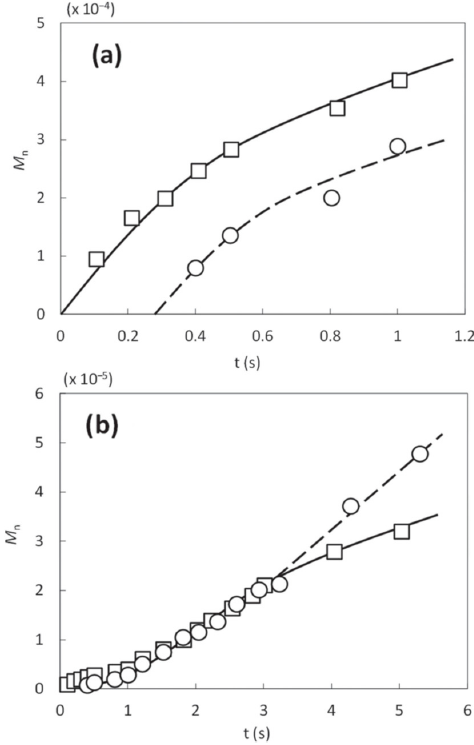
Figure 7. M n development in propylene polymerization at triisobutylaluminum concentrations of (o) 35 × 10 − 3 M, and ( □ ) 70 × 10 − 3 M: ( a ) Up to ca . 1.2 s; ( b ) Up to ca . 6 s [39].